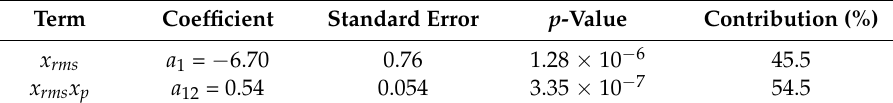
Table 4. The regression coefficients, standard errors, p -values, and contributions for the model of hardness with the non-ground sample data set. The intercept term is a 0 = 646.52.